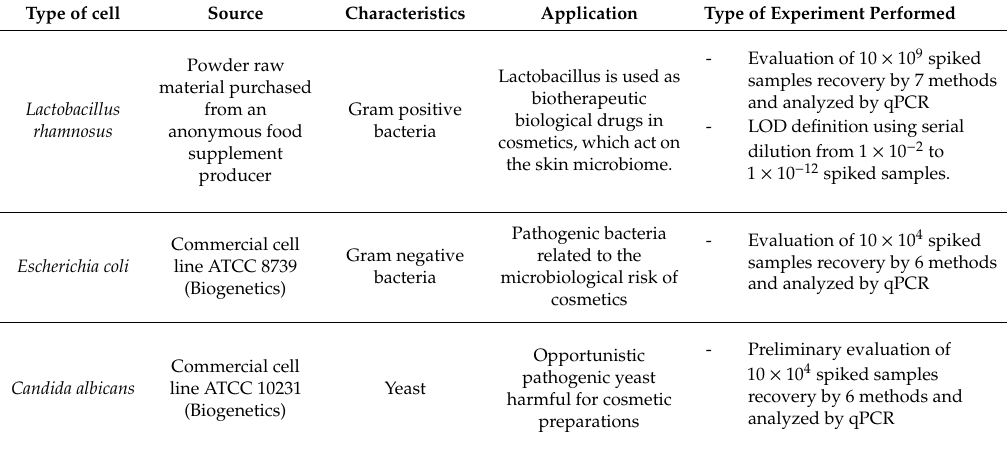
Table 2. Summary of microorganisms employed in the study for spike-in experiments and scheme of tests